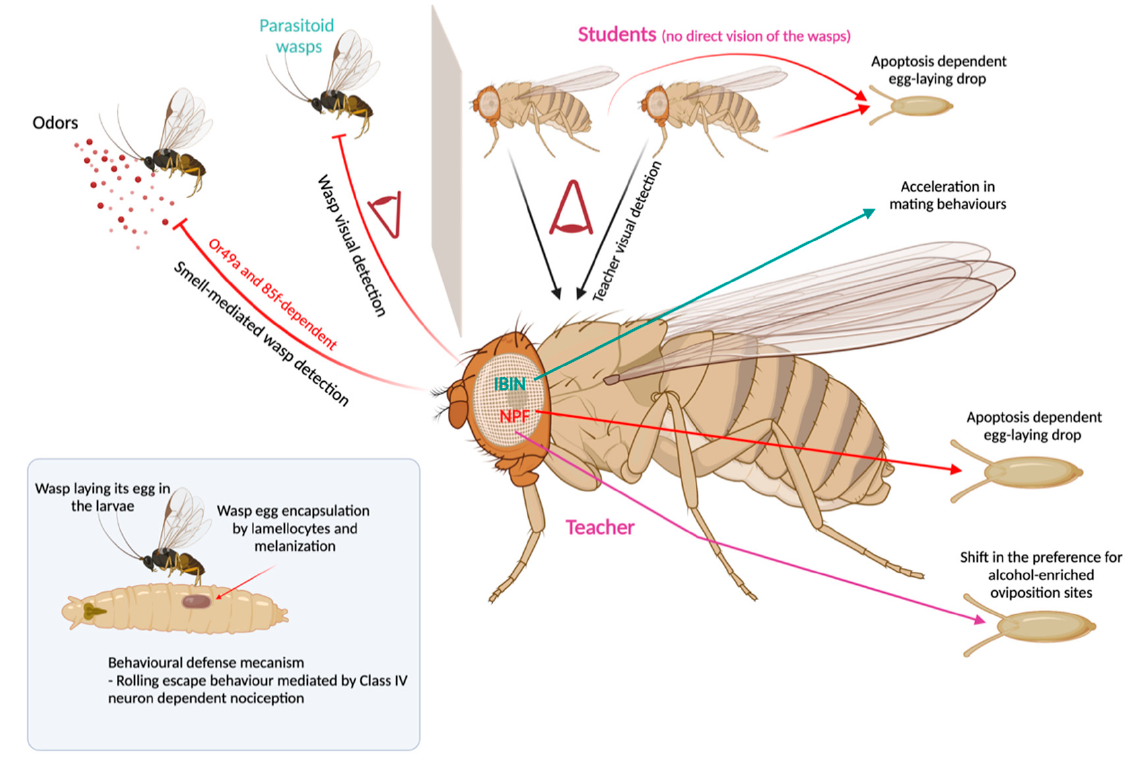
Figure 3. Drosophila –parasitoid wasp interactions (see text for details).